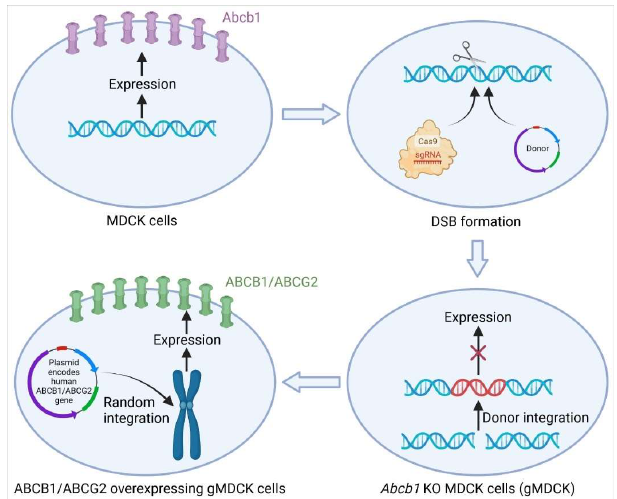
Figure 2. Schematic illustration of generating Abcb1 KO MDCK (gMDCK) cells and ABCB1/ABCG2 overexpressing gMDCK cells. After transfection, the target sequence is recognised and cleaved by the sgRNA-Cas9 complex, followed by the integration of the donor template through the HDR repair pathway. The expression of Abcb1 is thus disrupted in Abcb1 KO MDCK (gMDCK) cells. To generate ABCB1/ABCG2 overexpressing gMDCK cells, plasmids encoding human ABCB1 or ABCG2 genes are delivered into gMDCK cells and randomly integrated into the genome, leading to constant overexpression of ABCB1 or ABCG2 protein. Created with BioRender.com